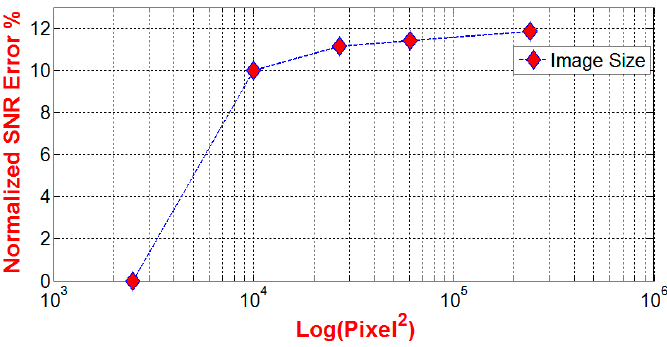
Figure 7. Semi log plot of the SNR error percentage, β , and the size of the reconstructed image based on modified TPS method.